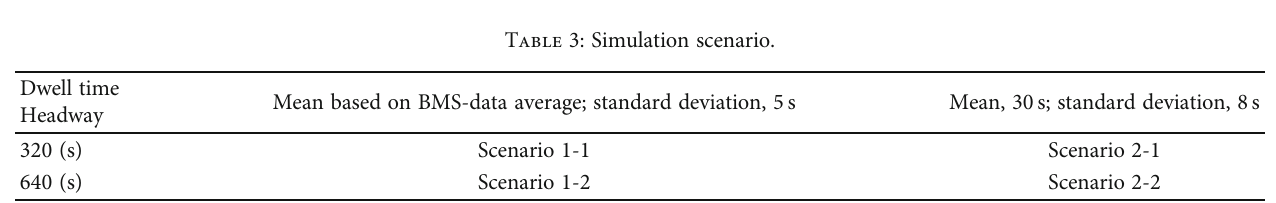
Figure 8: Location information of test site.